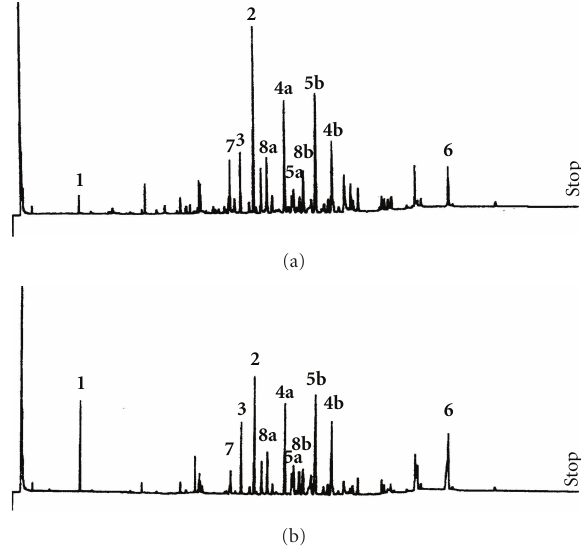
Figure 2: GC profile of secondary metabolites before (a) and after (b) germination of V. surinamensis seeds.